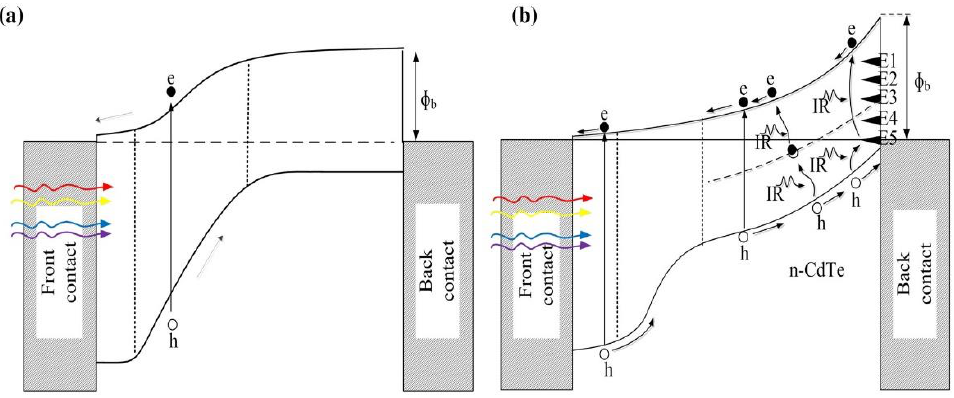
Figure 7. Energy band diagrams of two possible device configurations arising from glass/FTO/CdS/CdTe/metal system due to existence of CdTe in p-type ( a ), or n-type ( b ) electrical conduction [32,33].